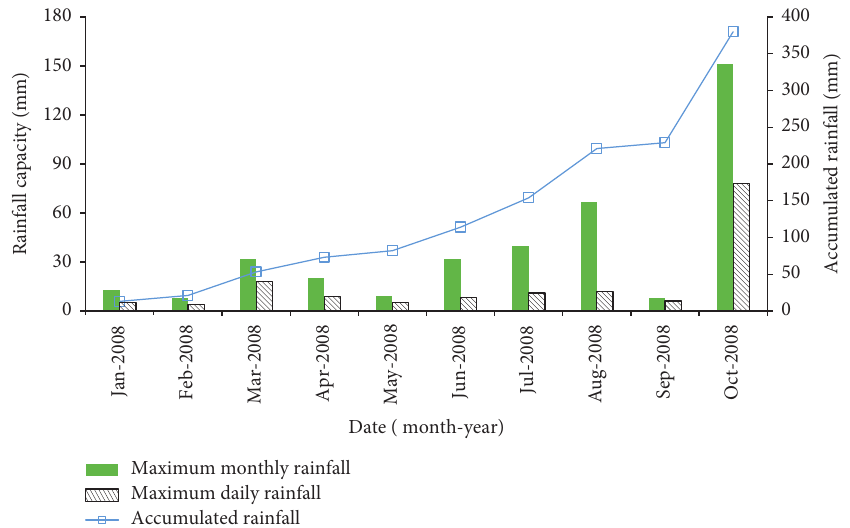
Figure 7: Rainfall recorded at the Liutongjiang Hydrologic Station before the landslide